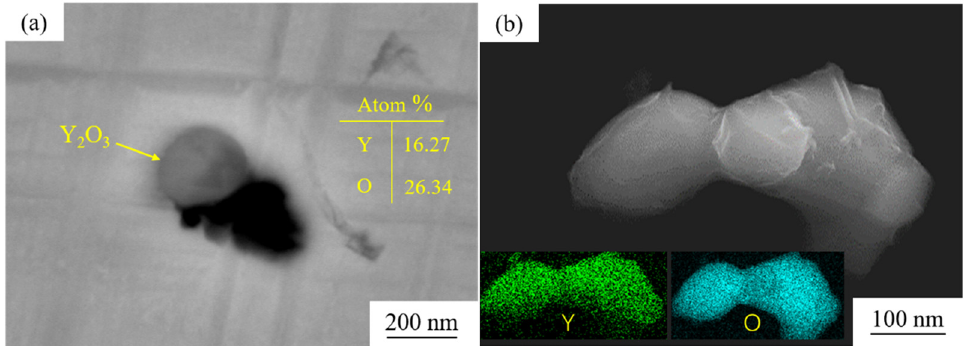
Figure 1: Morphologies of Y 2 O 3 in as - cast 9Cr3W3Co - ODS steel: ( a ) back scattered - electron imaging; ( b ) morphology of Y 2 O 3 extracted from steel.